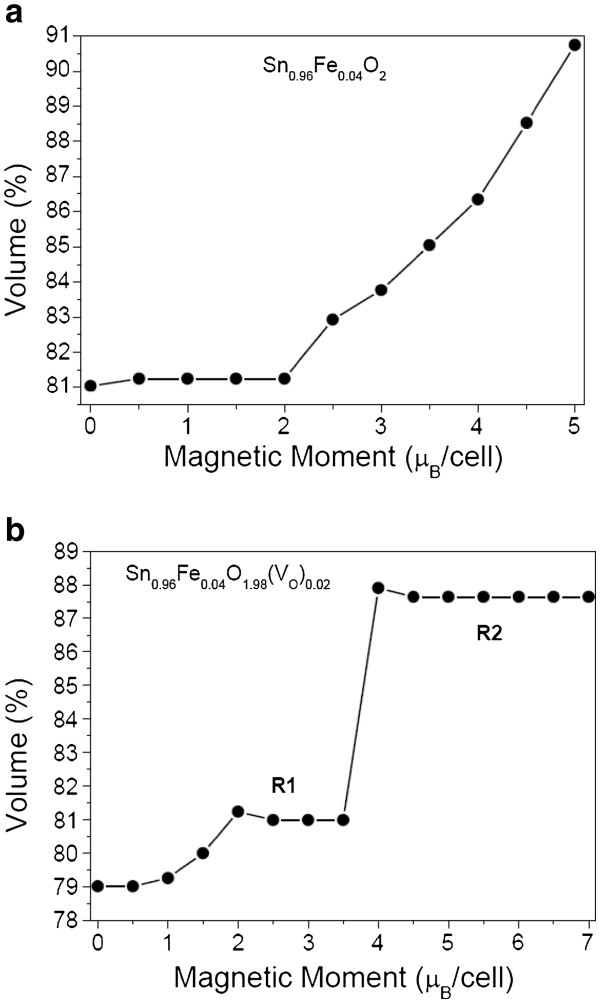
 Relative volume (%) around the iron atom vs. magnetic moment per cell. For (a) Sn0.96Fe0.04O2 and (b) Sn0.96Fe0.04O1.98(VO)0.02.